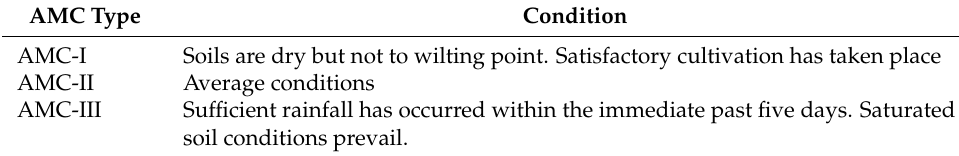
Table 6. Antecedent Moisture Condition (AMC)